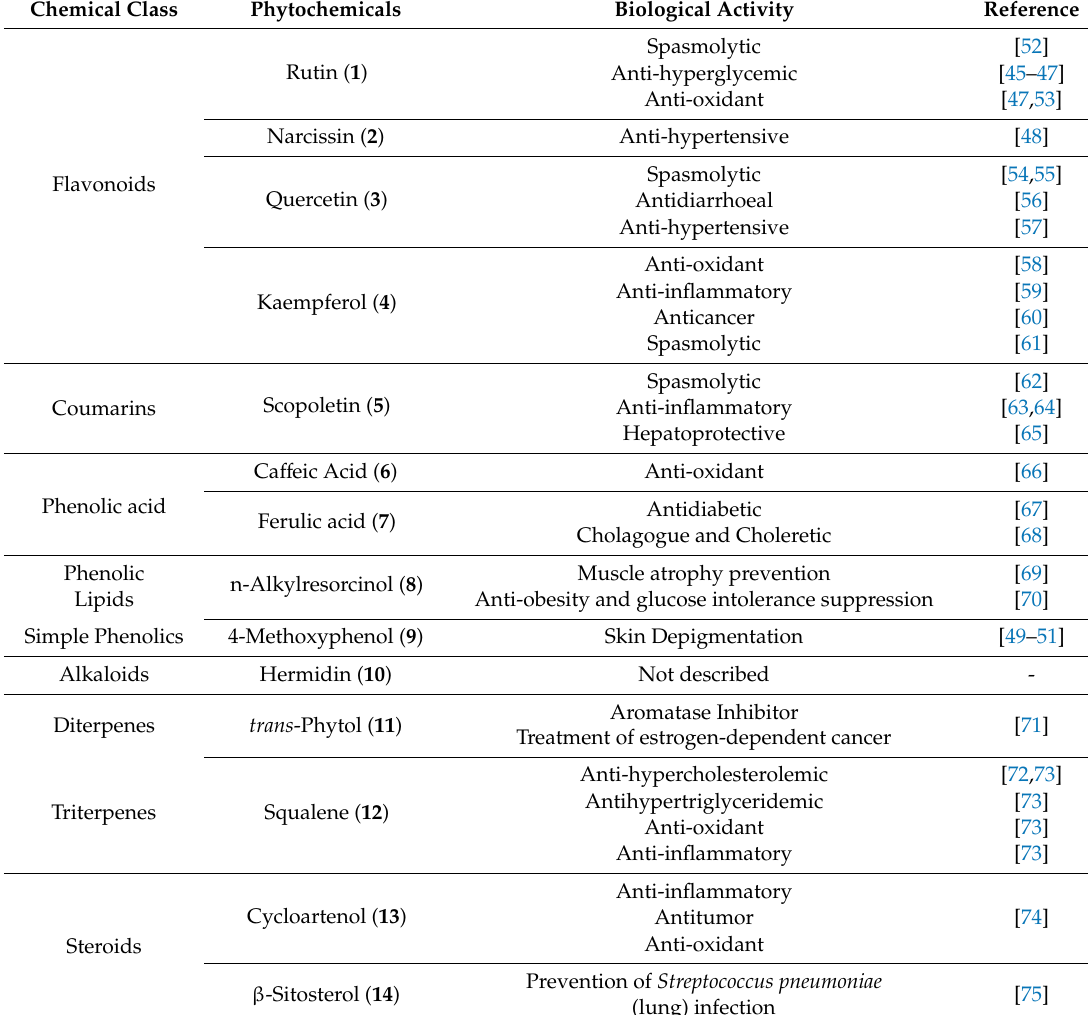
Table 2. Biological activity of selected phytochemicals from Mercurialis